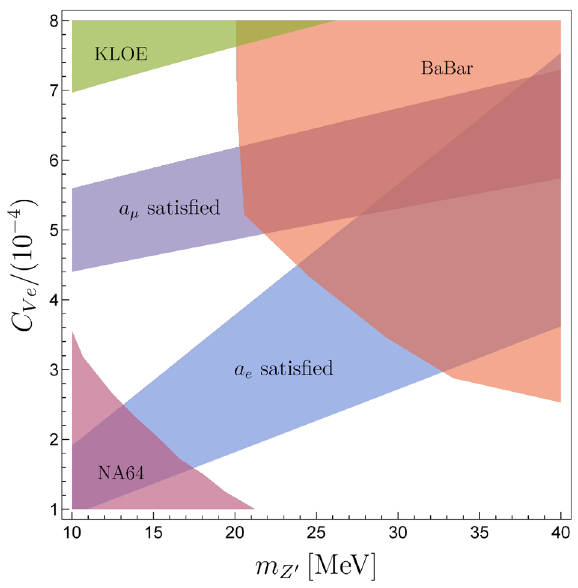
Fig. 4 Constraints on the mass and effective coupling of the Z (cid:2) , given the Rubidium measurement of a e . The bounds are on C Ve , where we have taken C Ae = − 10 − 8 / C Ae , saturating the Møller scattering con- straint (12), and fixed C V μ by Eq. (33), while setting all other effective couplings to zero. The blue (purple) stripe corresponds to where a e ( a μ ) is satisfied to within 1 σ . The pink region in the bottom left, green region in top left, and orange region in top right are ruled out by NA64, KLOE and BaBar, respectively. As can be seen, the region simultaneously sat- isfying a e and a μ is excluded by